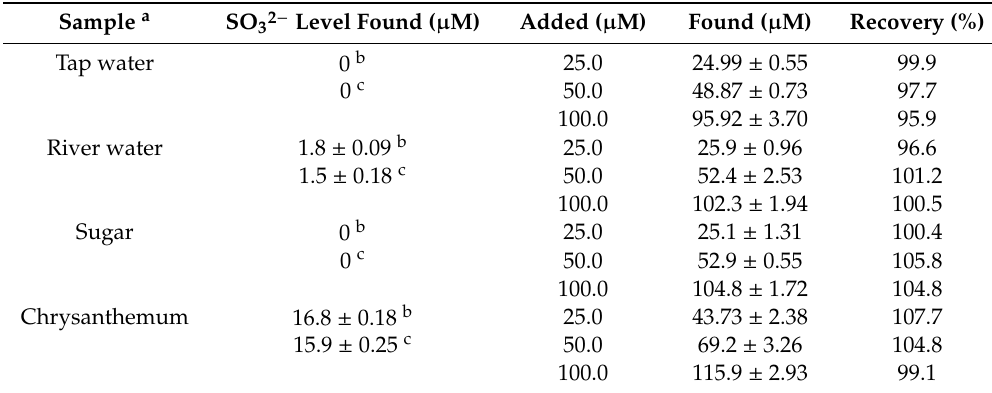
Table 1. Determination of SO 32 − in water samples using the probe EB .